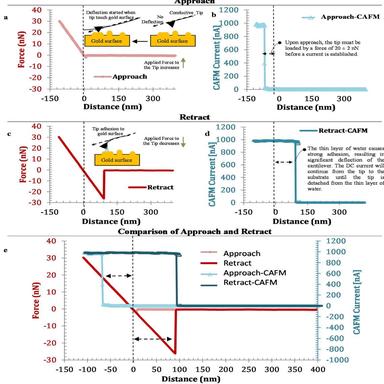
(a) FD curve including the detected current by CAFM on gold nanorods showing the increase and decrease in current at the point where the conduction has been established, (b) the other cases when more force required to establish the current between tip and gold nanorod surface and also more adhesion shows in retract graph, this trend was observed only in 7 tested nanorods. This "contact first, then current" behaviour reported as the presence of a thin layer of adsorbates (or nanoscale contamination) on the